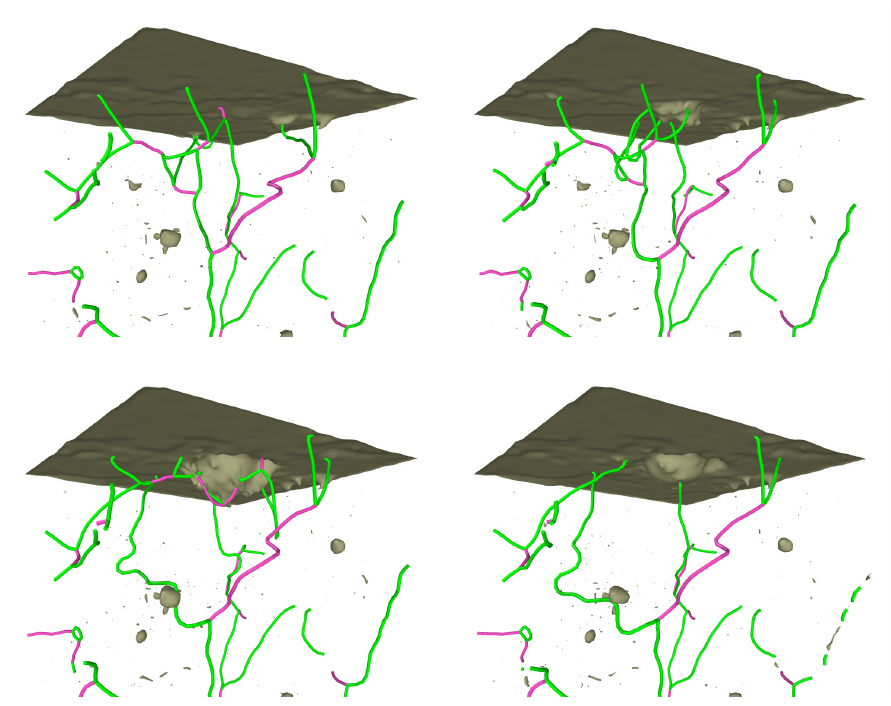
Figure 3. Sequence of indentation and release in a Fe sample with pre-existing defects, see text. Original contribution of the